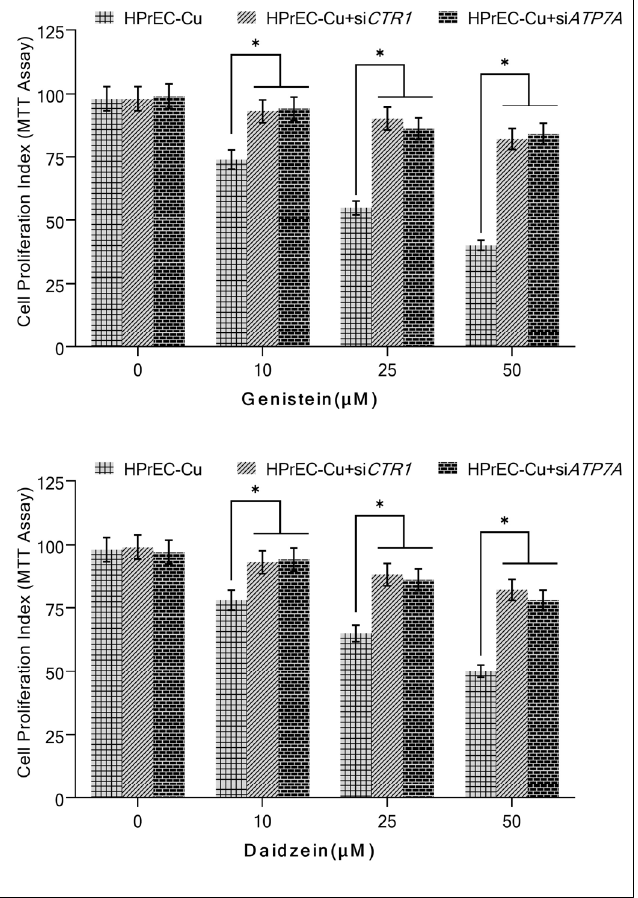
Figure 9. The effect of isoflavones on cell proliferation of HPrEC-Cu cells (normal HPrEC cells cultured in a medium containing 25 µ M CuCl 2 ) was compromised after the knock-down of CTR1 and ATP7A . HPrEC-Cu cells were initially treated for 48 h with targeted siRNA against CTR1 ( siCTR1 ) and ATP7A ( siATP7A ), followed by 96 h with the indicated doses of genistein/and daidzein. Values reported are mean ± S.E. of three independent experiments. * p value < 0.01 when compared to respective control.